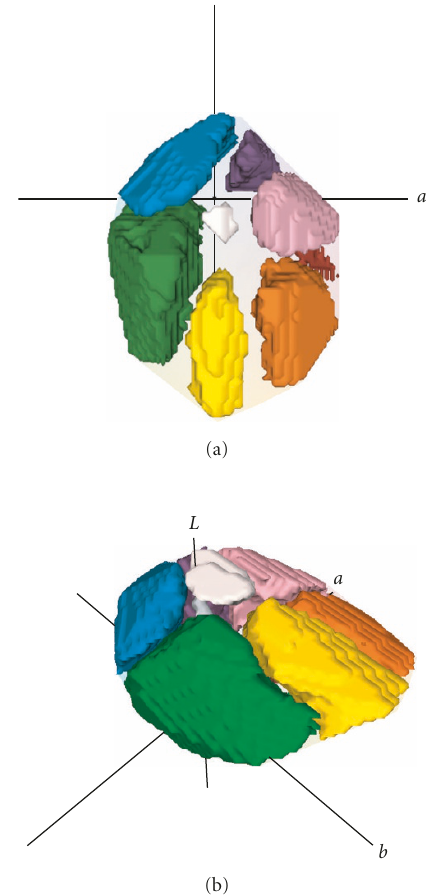
Figure 7: Surfaces delimiting the 11 color categories corresponding to a membership value (a) p = 0 . 8; (b) p = 0 . 5.